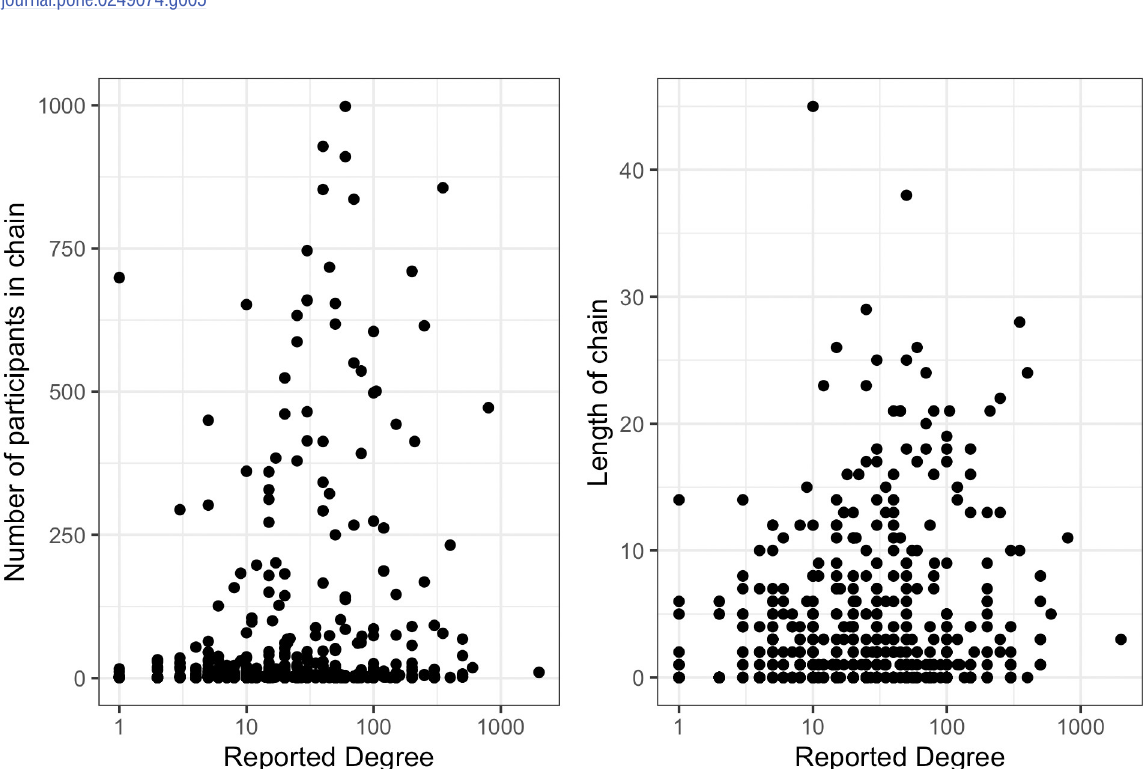
Fig 6. Seed degree and recruitment. Relationship between reported degree of seed and the length and number of participants in recruitment chains.